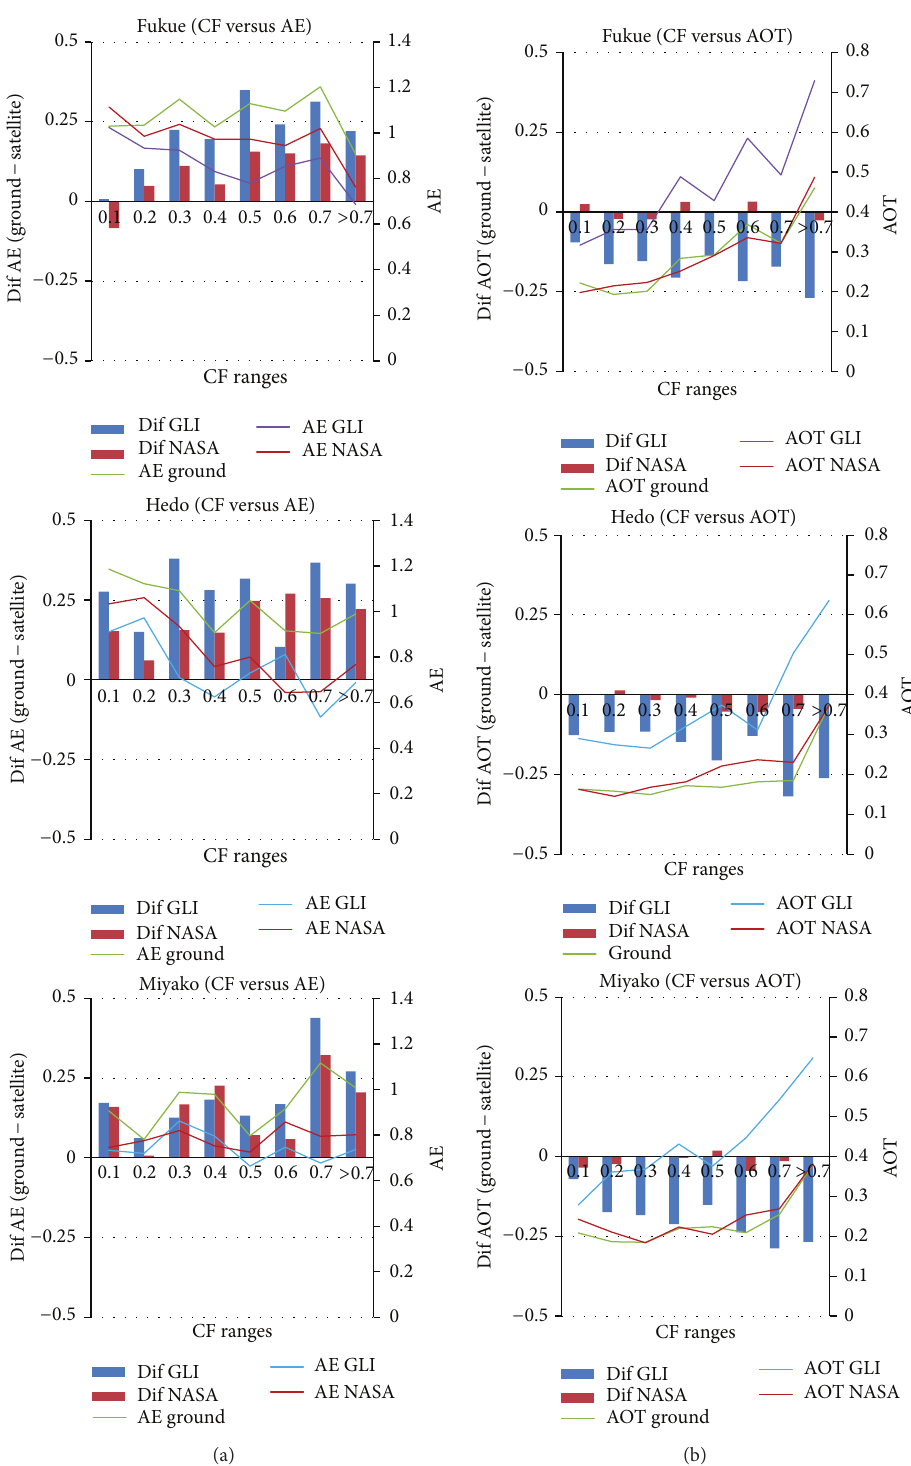
Figure 6: Cloud fraction (CF) variation against aerosols properties retrievals from ground (AE and AOT ground), MODIS-GLI (AE and AOT GLI), and MODIS-NASA (AE and AOT NASA). Then CF variation against satellite bias, that is, difference ground-satellite (ground AE or AOT-MODIS-GLI AE or AOT), (ground AE or AOT-MODIS-NASA AE or AOT), during the 3 years of observations. The AE or AOT scales are on the right while the scale of the Dif is on the